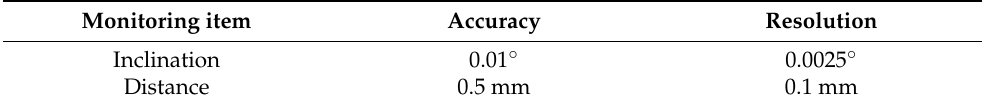
Table 1. The accuracy and resolution of the Omni tilt and distance